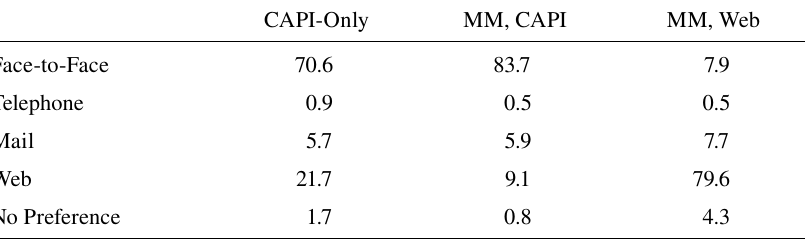
Mode Preference at Wave 6, by Mode of Response (in Percent) CAPI-Only MM, CAPI